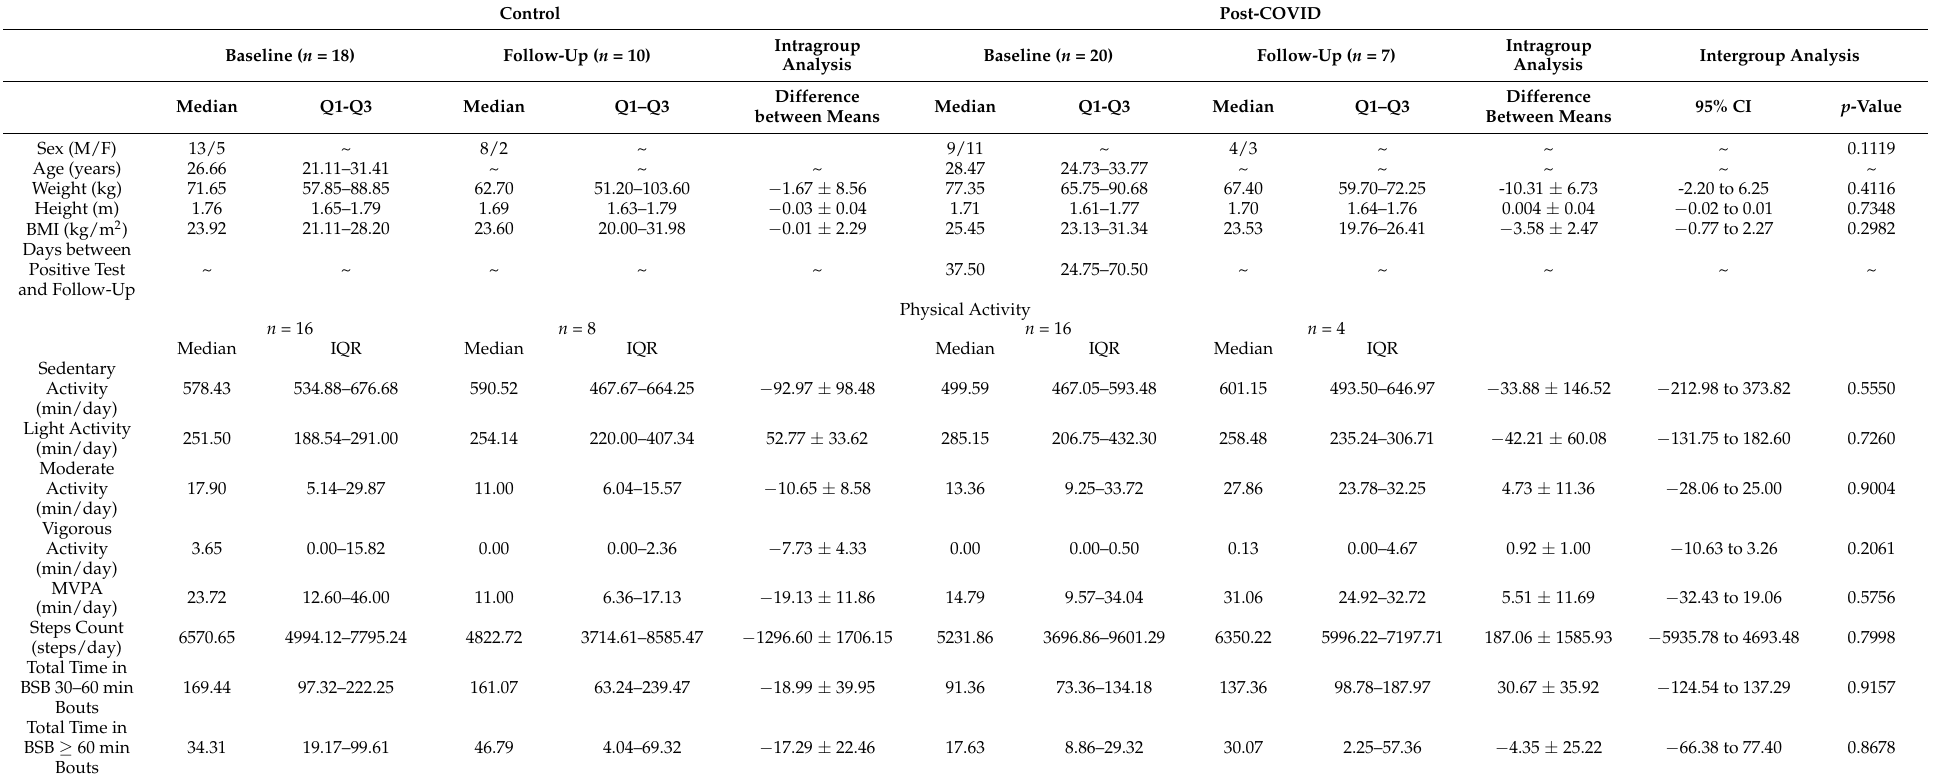
Table 2. Sample characterization and physical activity